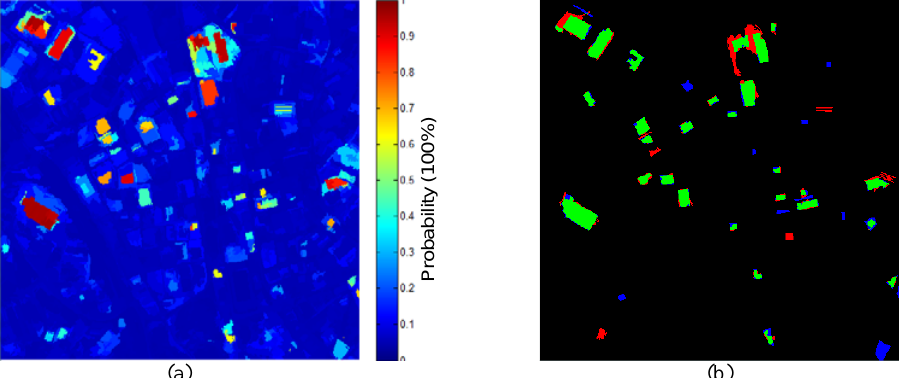
Figure 7. Change map (a) and change mask (b) generated in the Istanbul test area with Method I.